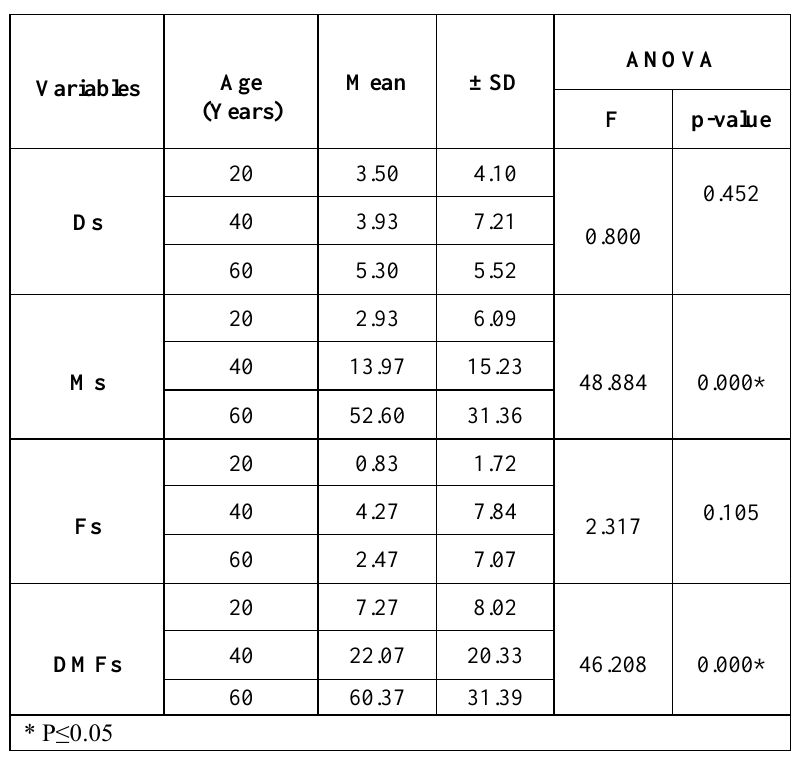
Table 3: Caries experience by DMFs index and its fractions among different ages